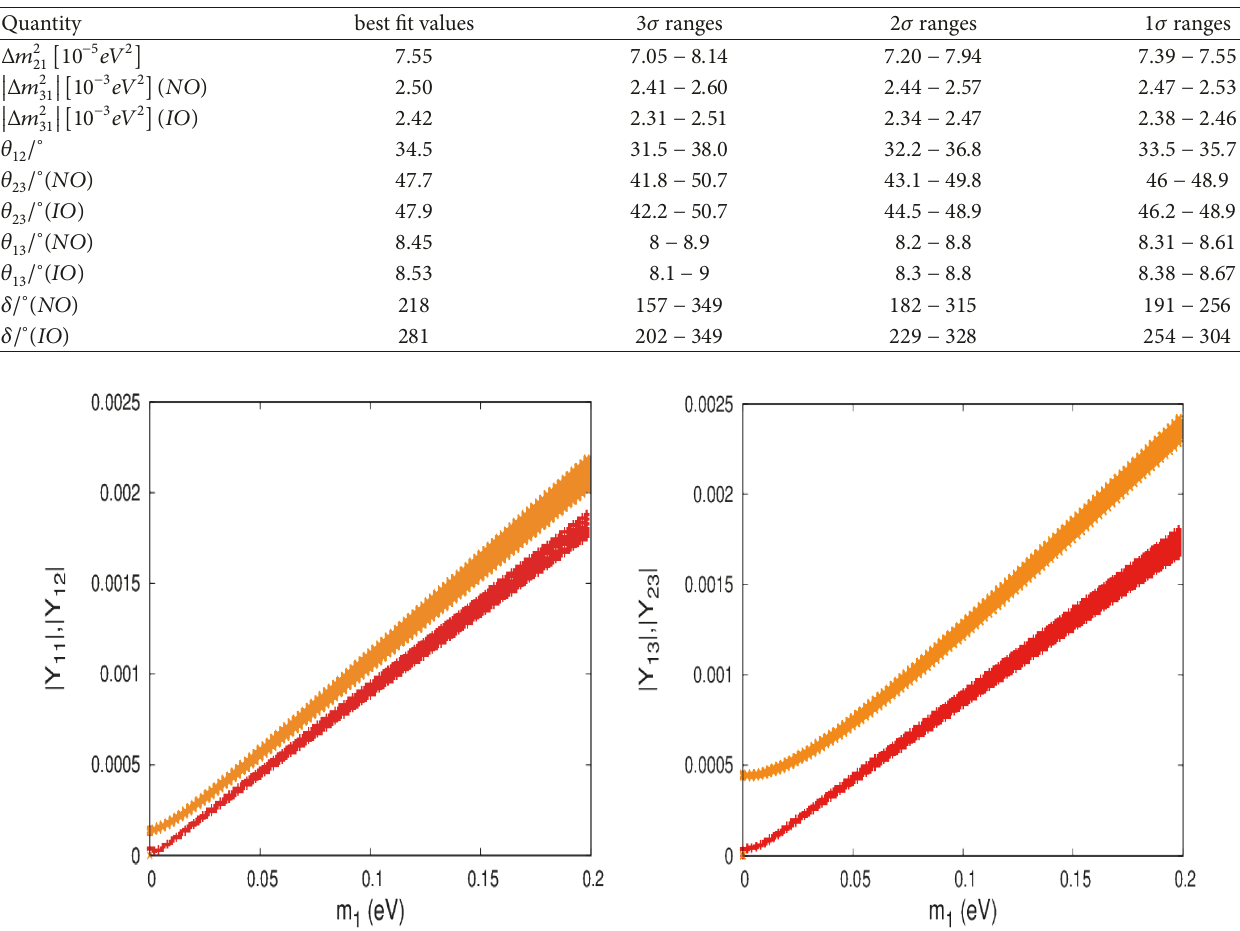
| and |𝑌 | , respectively. In (b) red patch gives values of |𝑌 | whereas 11 12 13